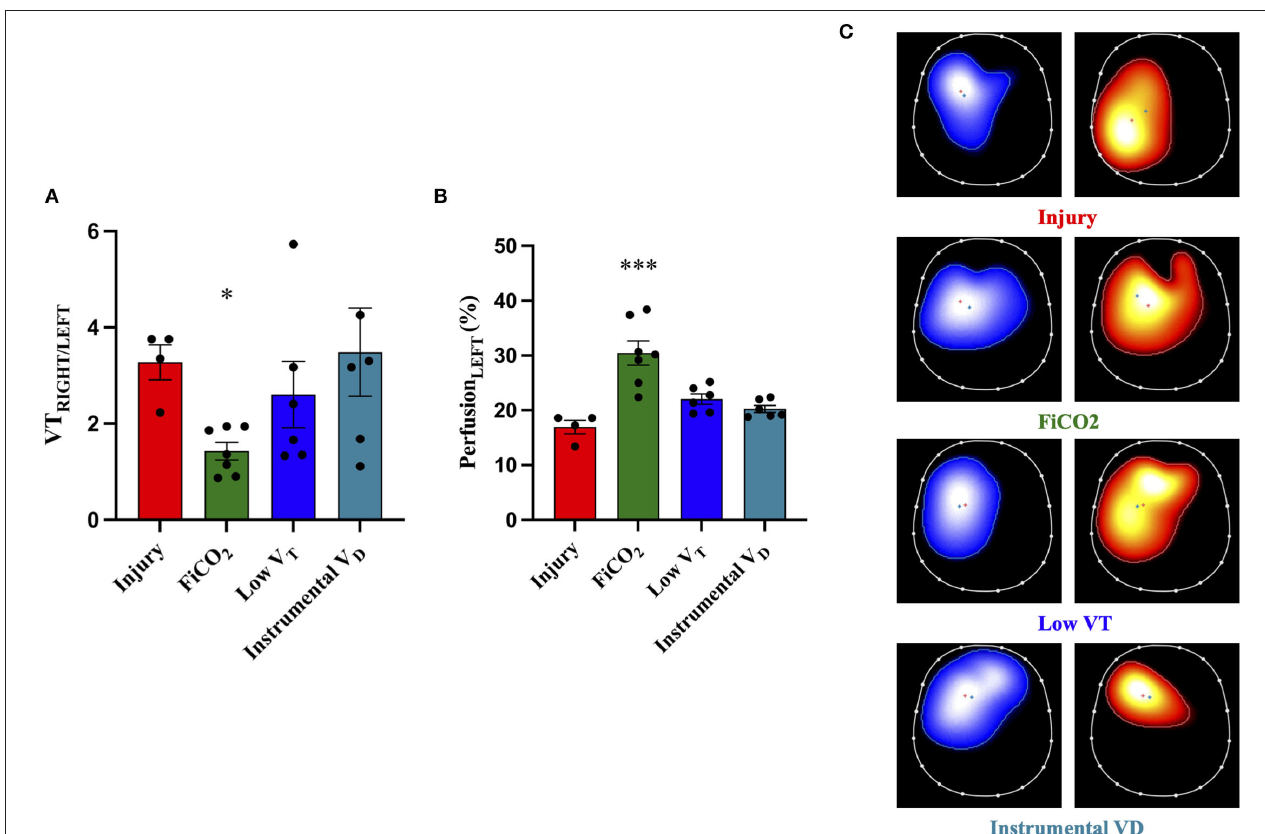
FIGURE 5 | Distribution of ventilation and perfusion by EIT. The ratio between tidal volume distending the right and the left lung [V TRIGHT / LEFT , (A) ] at 2h after ligation of the left pulmonary artery shows significant imbalance in all the study groups, which was decreased only by FiCO 2 . The percentage of blood flow to the left lung [Perfusion LEFT , (B) ] throughout the experiment (average between T2 and T48) was higher in the FiCO 2 group compared to the other groups. Representative EIT images for ventilation (blue maps), perfusion (red maps), and distribution (C) showed increased ventilation and perfusion of the left lung in the FiCO 2 group. Data are expressed as mean ± SEM. Comparisons are obtained with ordinary one-way ANOVA or Kruskal–Wallis test for normally and non-normally distributed values, respectively, followed by Dunnett or Dunn’s multiple comparison test. * p < 0.05, *** p < 0.001 vs. Injury